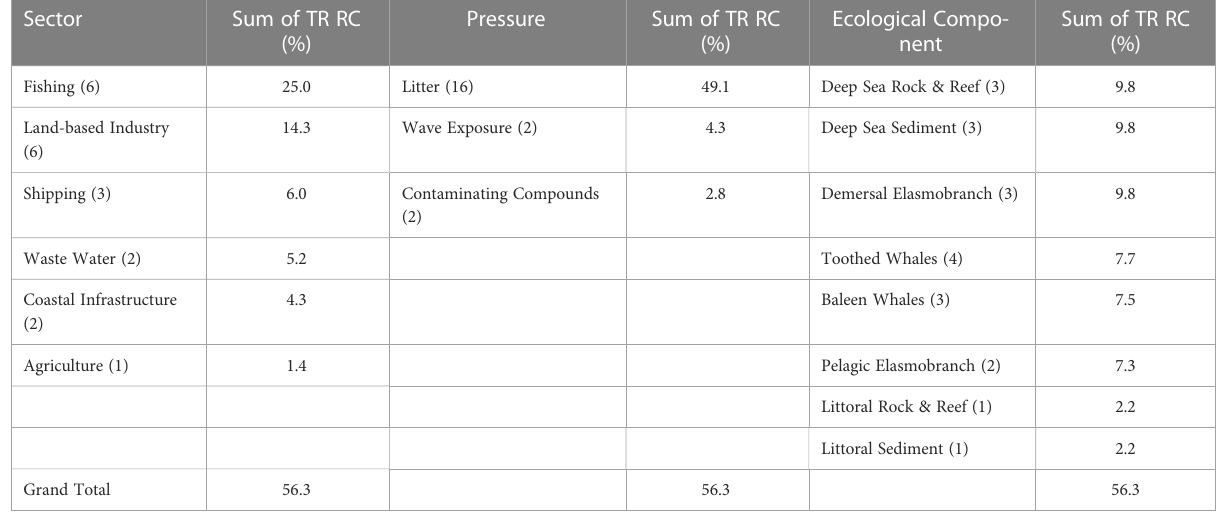
TABLE 6 The Sectors, Pressures and Ecological Components present in the top linkage chains as identi fi ed from the Relative Contribution (RC) to Total Risk Scores. Sector